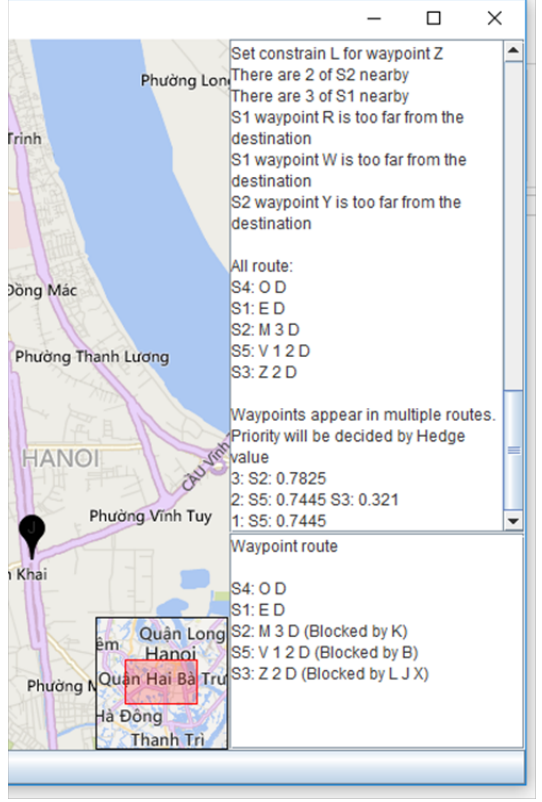
Figure 7. Priority service vehicles moved as they appear on the Google map.